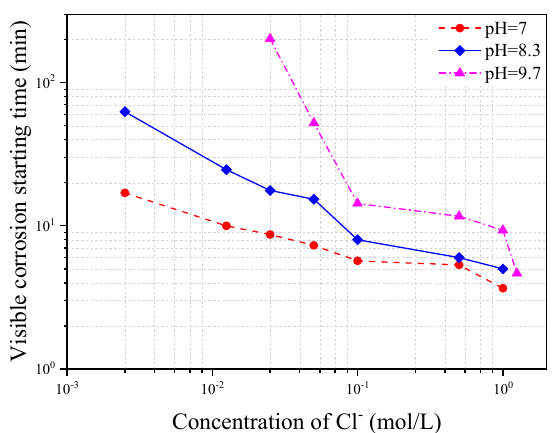
Figure 13. Variation of corrosion starting time with chloride concentration in three di ff erent types of Figure 15. Variation of corrosion starting time with chloride concentration in three different types of simulated concrete pore solutions. simulated concrete pore solutions.